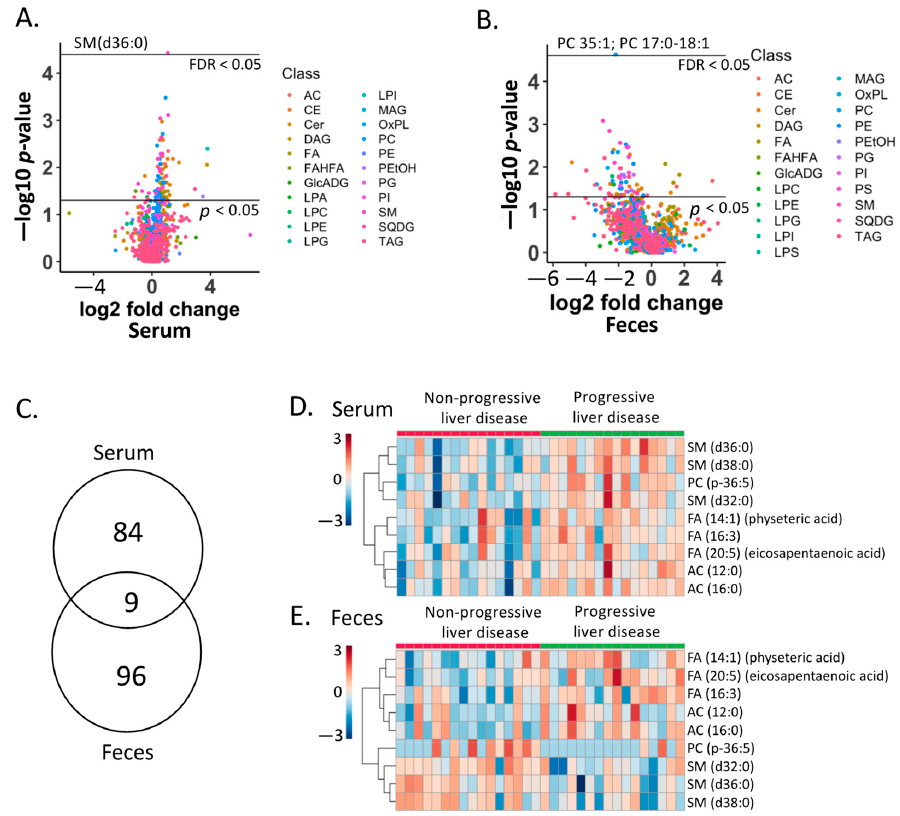
Figure 3. Comparison between progressive liver disease and non-progressive liver disease. ( A ) Vol- cano plot of the serum lipidome for the two patient groups. Different colors represent different lipid class. Fold change: progressive liver disease ( n = 16)/non-progressive liver disease ( n = 16). ( B ) Vol- cano plot of the fecal lipidome for the two patient groups. Different colors represent different lipid class. Fold change: progressive liver disease ( n = 16)/non-progressive liver disease ( n = 16). ( C ) Venn diagram of significant fecal lipids ( p -value < 0.05). ( D ) Heatmap of nine serum lipid biomarkers. ( E ) Heatmap of nine fecal lipid biomarkers. SM: sphingomyelin; PC: phosphatidylcholine; FA: fatty acid; AC: acylcarnitine.